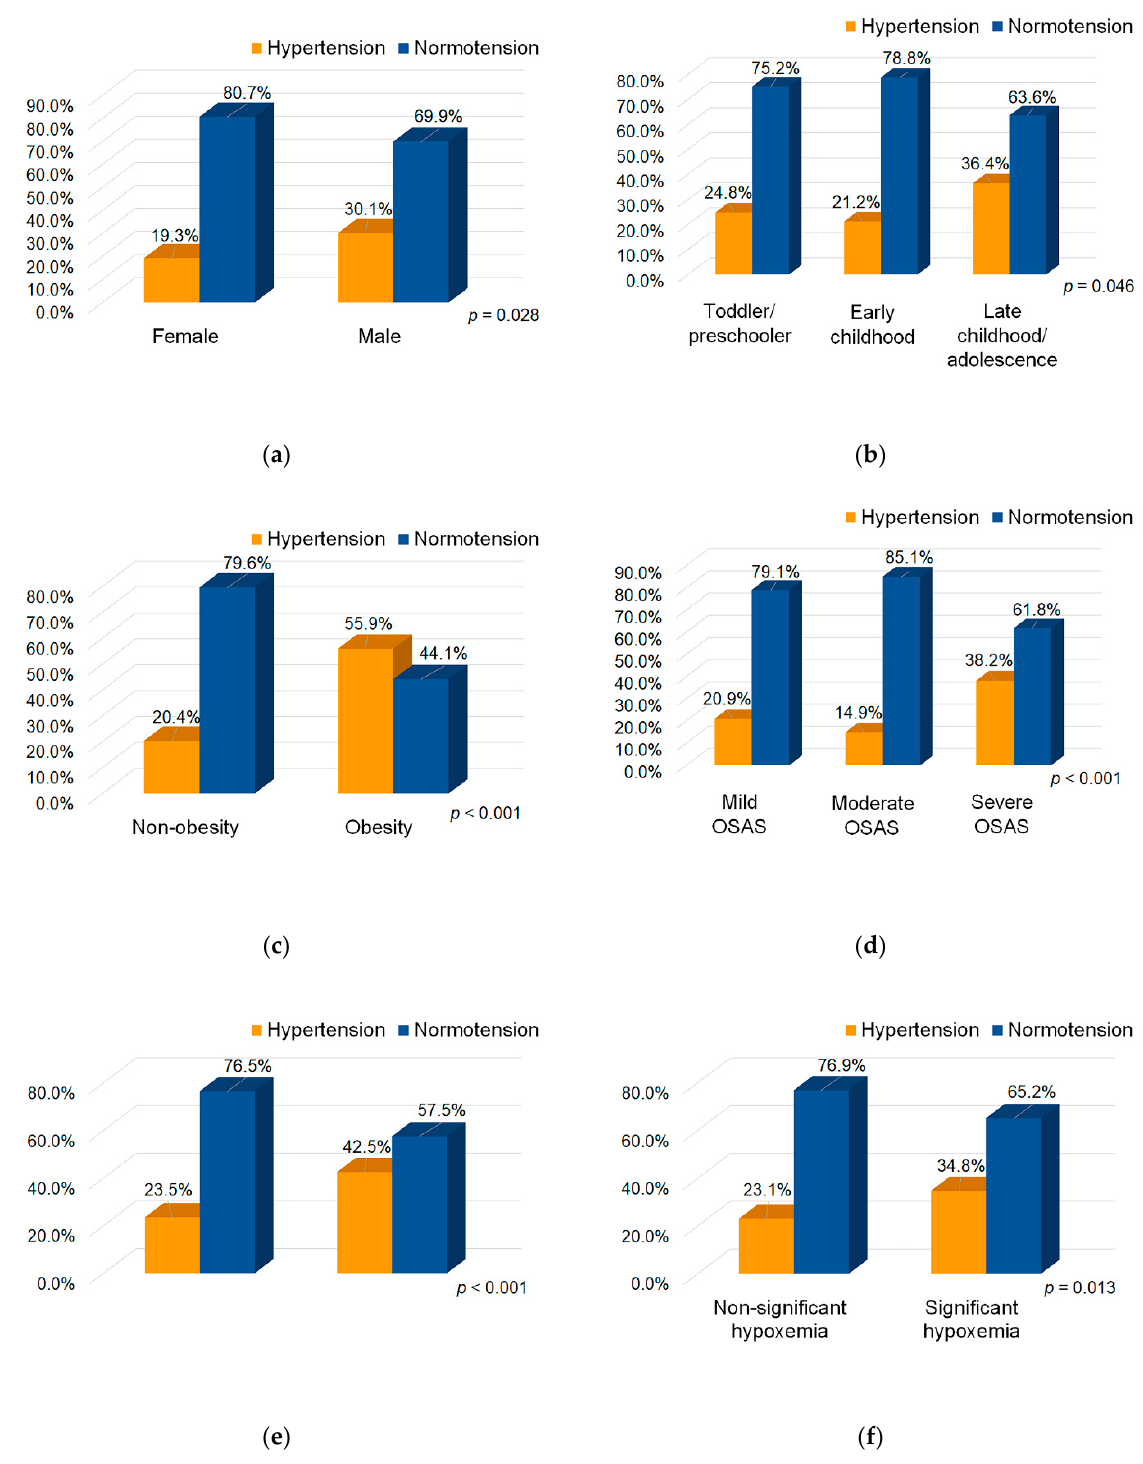
Figure 2. Bart charts demonstrate the relationships between hypertension and different clinical variable subgroups. ( a ) Sex subgroups; ( b ) Development stage subgroups; ( c ) Obesity subgroups; ( d ) Disease severity subgroups; ( e ) Abnormal oxygen saturation subgroups; ( f ) Significant hypoxemia subgroups. Abbreviations: OSAS: obstructive sleep apnea syndrome; SpO 2 : oxygen saturation.